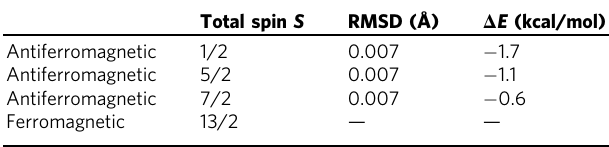
Table 1 Spin con fi gurations and the resulting optimized Mn 4 CaO 5 geometries (in Å) and energies (in kcal/mol) calculated for antiferromagnetically coupled Mn ions with respect to ferromagnetically coupled Mn ions in S